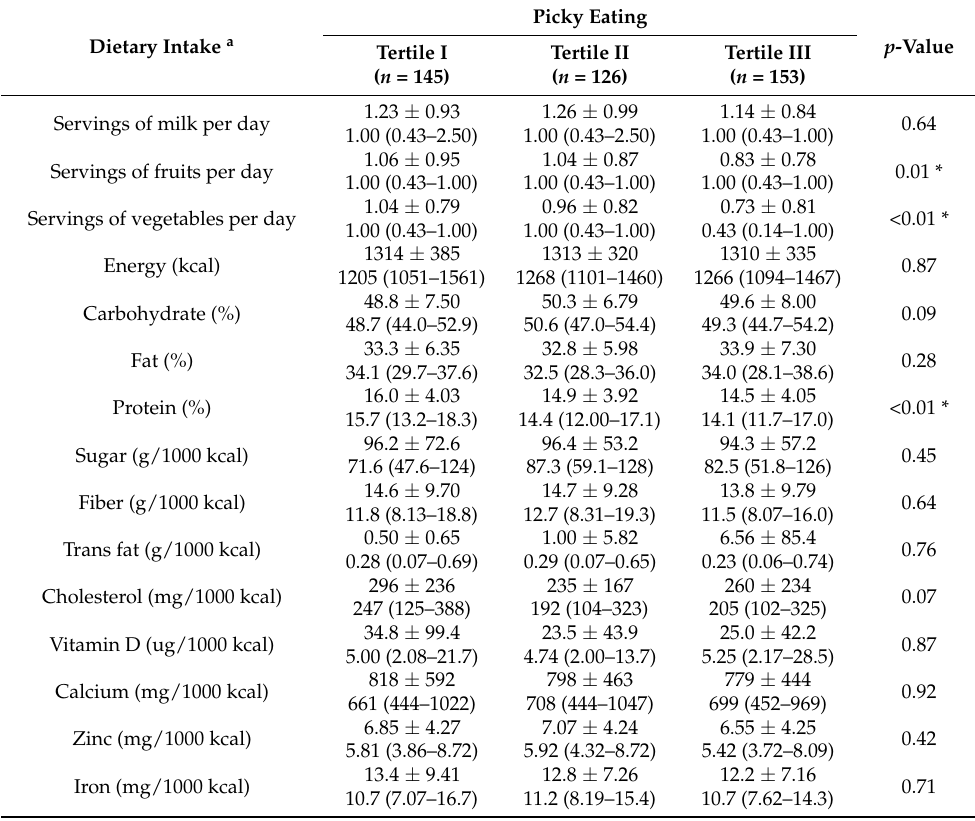
Table 3. Dietary intakes of children stratified by tertiles of picky eating.